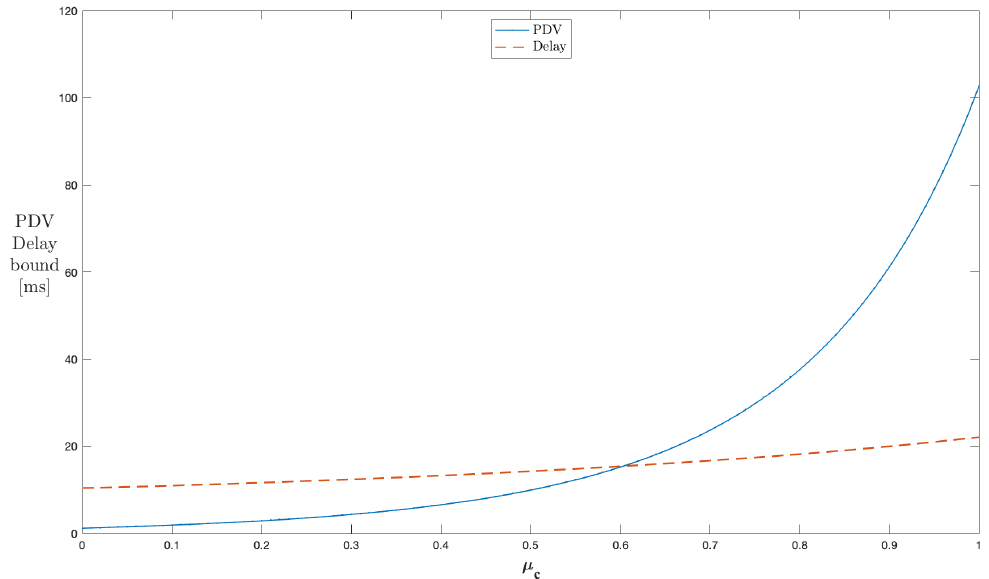
Figure 6. Impact of µ c on the PDV bound in a single-stage network (constant λ c